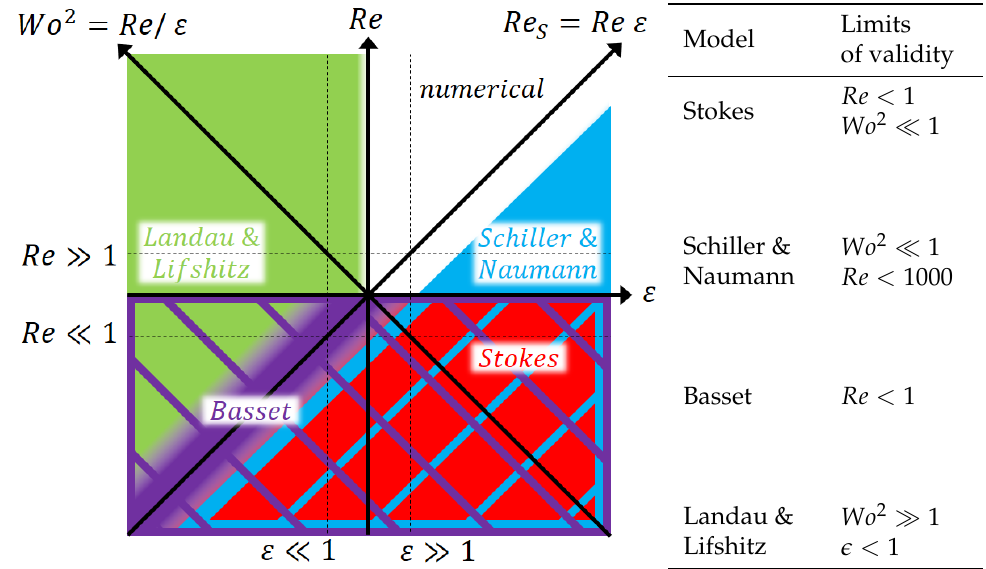
Figure 1. Drag models considered for various combinations of Reynolds number Re , amplitude parameter (cid:101) , and Womersley number Wo 2 . ( left ) Various drag models displayed in the (cid:101) - Re plane. The striped patterns indicate the areas of validity, while the solid colors mark the preferable model in the area. Note that the origin has the coordinates (cid:101) = 1, Re = 1. ( right ) Various drag models with their limits of validity.